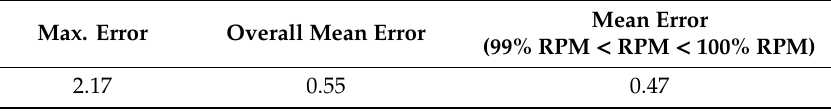
Figure 14. VIGV angle measurement results from engine test.